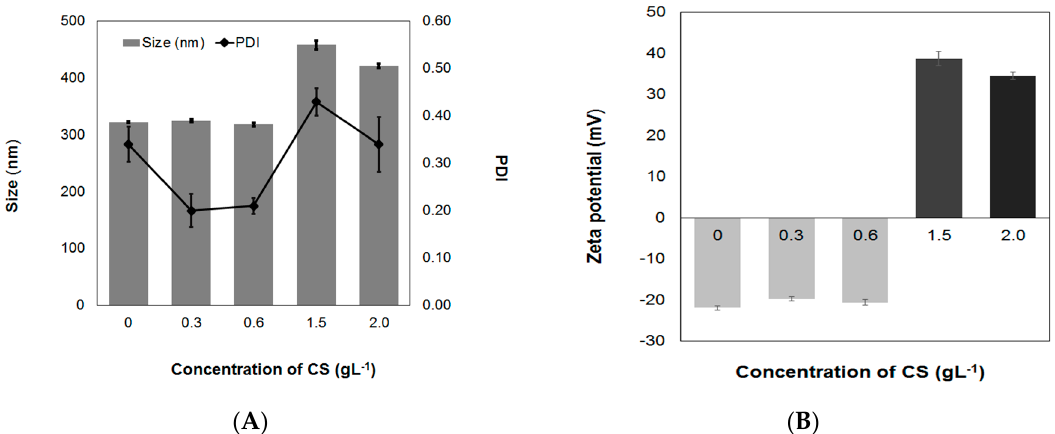
Figure 4. Effect of CS concentration on the properties of sacha inchi oil loaded CS-AL nanoemulsion. ( A ) Size/PDI and ( B ) zeta-potential.